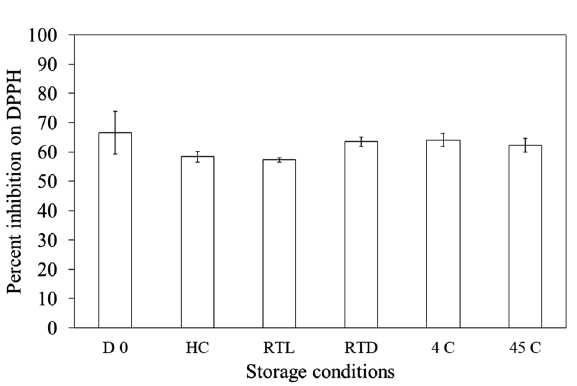
Figure 3. DPPH scavenging capacities of the extract-loaded emulsion (CE) at the initial and after storage under various conditions; 6 cycles of HC, RTL, RTD, 4 °C, and 45 °C.